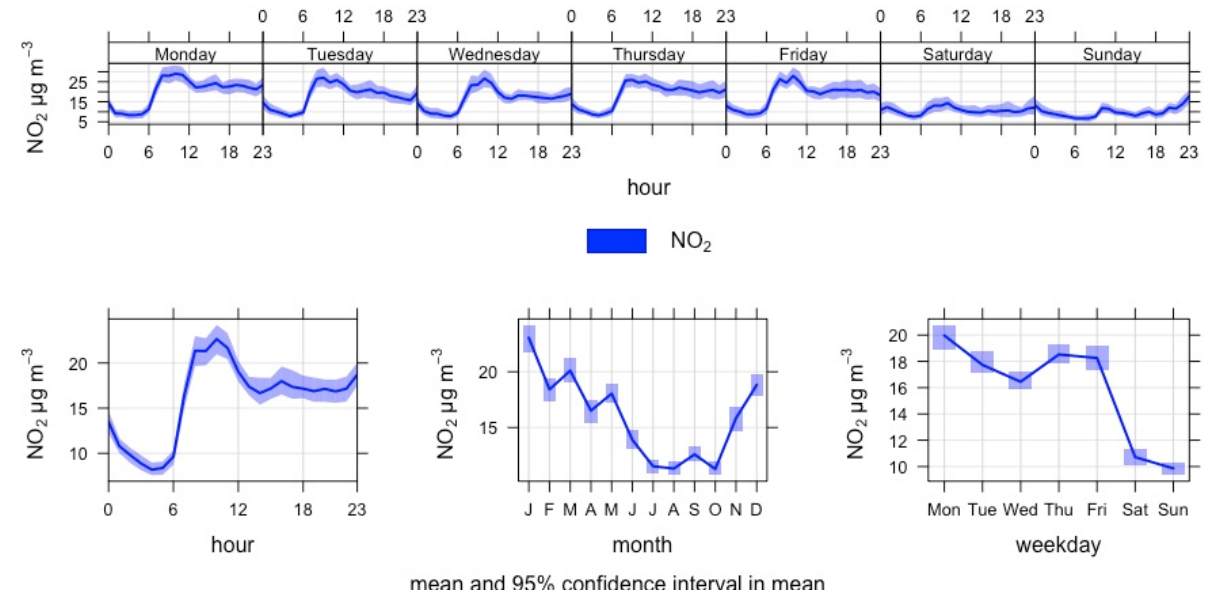
Figure 6. Time variation plot of NO 2 concentration at Vuosaari port terminal of Helsinki in 2016. The multivariable linear regression shows a statistically significant ( p < 0.05) association between vessel arrivals, departures, movement and lying at berth and the natural logarithm of hourly mean NO 2 concentrations when adjusted for wind direction, wind speed, relative humidity, air temperature and time of day (Table 4). Arrivals correspond to a 25.1% increase (95% CI 21.4–29.0%) of the measured hourly mean NO 2 concentration. However, arrivals were not statistically significant ( p = 0.873) when the analysis was run with measurements conducted during weekends only. The effect of departures was consistent with both anal- yses. Each ship departure corresponds to an increase of 16.3% in the hourly mean NO 2 (95% confidence interval 12.5–20.3%). All vessel movements (arrivals and departures com- bined) correspond to an increase of 21.3% (95% confidence interval 18.5–24.0%) during the whole year, and to 6.4% (95% confidence interval 1.1–11.9%) during the weekends only. Ves- sels at berth correspond to an increase of 6.0% (95% confidence interval 5.4–6.5%) during the whole year and 1.5% (95% confidence interval 0.5–2.6%) during the weekends only. The models for the whole year explain 24–27% and the weekend models 30–31% of the variance in the hourly mean NO 2 concentration. The diagnostic plots (supplement) indicate an even distribution of the model residuals and some expected collinearity as the weather parameters correlate with each other and the vessel movement to the time of day. Based on the analyses, the association between vessel movement and increased NO 2 concentrations seems strong, and departures show the most consistent